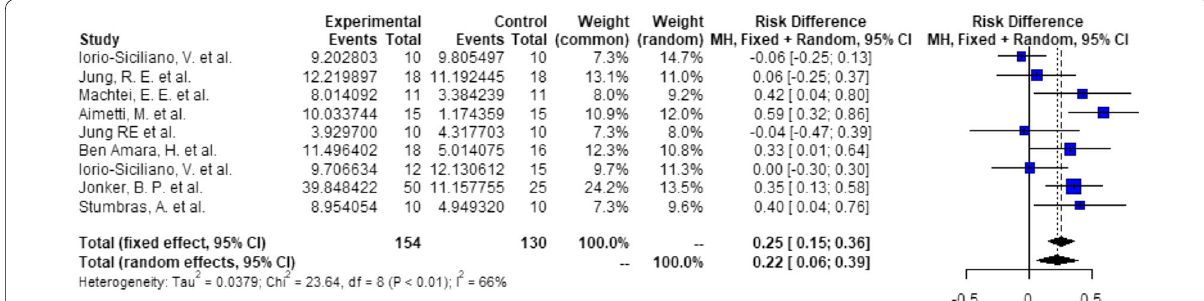
Fig. 6 Meta-analysis results for the binary outcomes for implant placement in a bone envelope of 6.0 mm